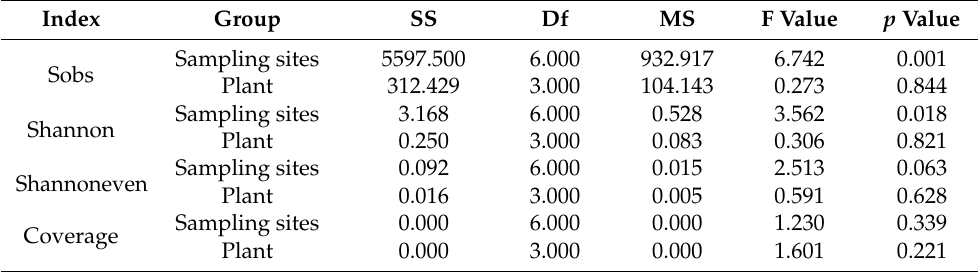
Table 1. Significance levels (F values) of the effects of sampling sites and plant on Sobs, Shannon, Shannoneven, and Coverage indexes of arbuscular mycorrhizal fungi (AMF) based on a one-way analysis of variance